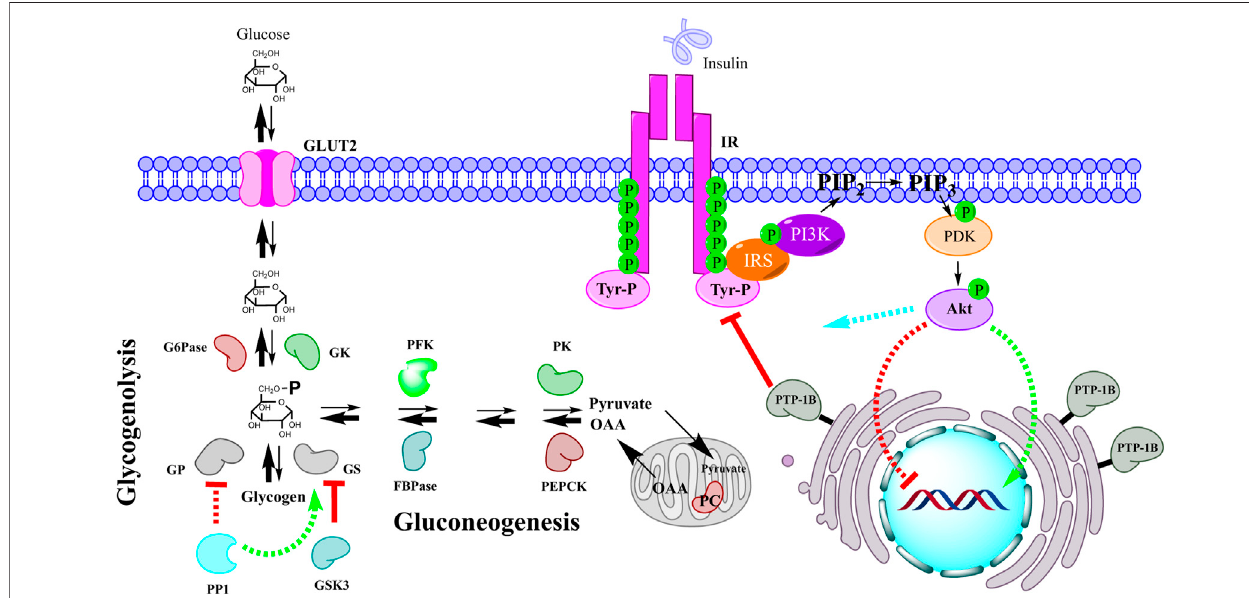
FIGURE 2 | Impaired hepatic glucose homeostasis by insulin resistance. When insulin does not work properly either due to overexpression of PTP-1B or other factors, glucose production in liver is upregulated generating a hyperglycemic state. Both gluconeogenesis and glycogenolysis are enhanced due to poor insulin signaling, namely genetic expression of gluconeogenic enzymes is not repressed and enzymes related to glycogen metabolism are not adequately regulated. Akt functions:greencolorindicatespositiveregulation,redcolorindicatesnegativeregulation,andbluecolorrepresentsdirectorindirectregulationbyphosphorylation or allosterism. IR: insulin receptor; IRS: insulin receptor substrate; PI3K: phosphoinositide 3-kinase; PIP2: phosphatidylinositol 4,5-bisphosphate; PIP3: phosphatidylinositol 3,4,5-triphosphate; PDK: phosphoinositide-dependent kinase; Akt: protein kinase B; PTP-1B: protein tyrosine phosphatase 1B; PC: pyruvate carboxylase;OAA:oxalacetate;PEPCK:phosphoenolpyruvatecarboxykinase;PK:pyruvatekinase;FBPase:fructose1,6-bisphosphatase;PFK:phosphofructokinase; GS: glycogen synthase; GP: glycogen phosphorylase; PP1: protein phosphatase 1; GSK3: glycogen synthase kinase-3; GK: glucokinase; G6Pase: glucose 6- phosphatase; GLUT2: glucose transporter